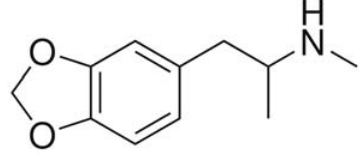
Figure 1. Chemical structures of the main compounds cited in this